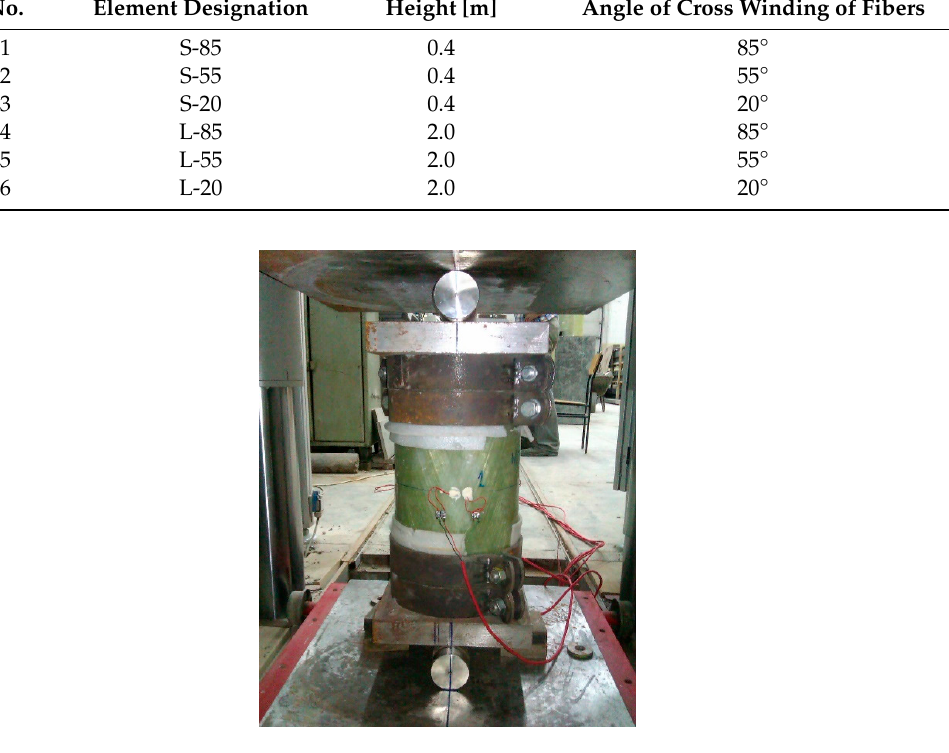
Figure 1. Test element for measuring the mechanical properties of a composite during compression: empty tube with winding angle of 20° on a test stand.